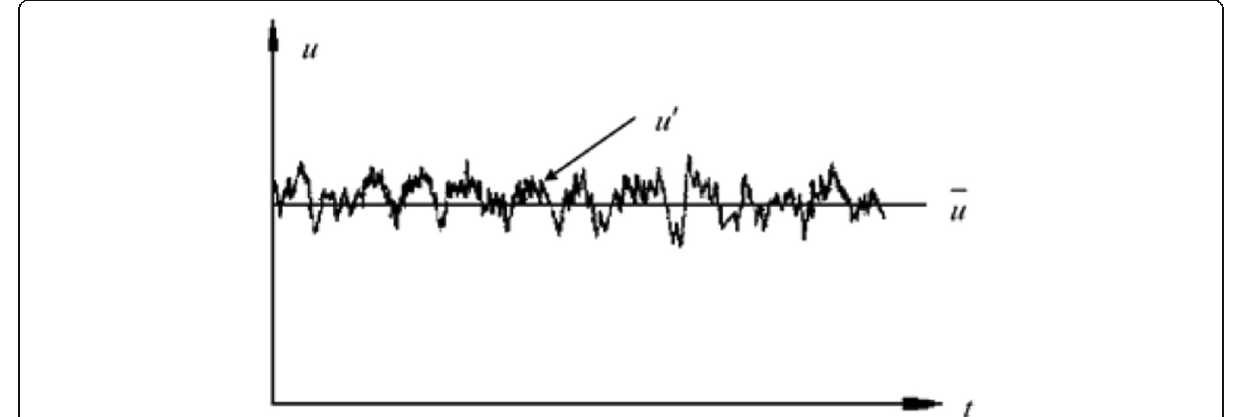
Fig. 2 Measured speed of turbulence at a certain